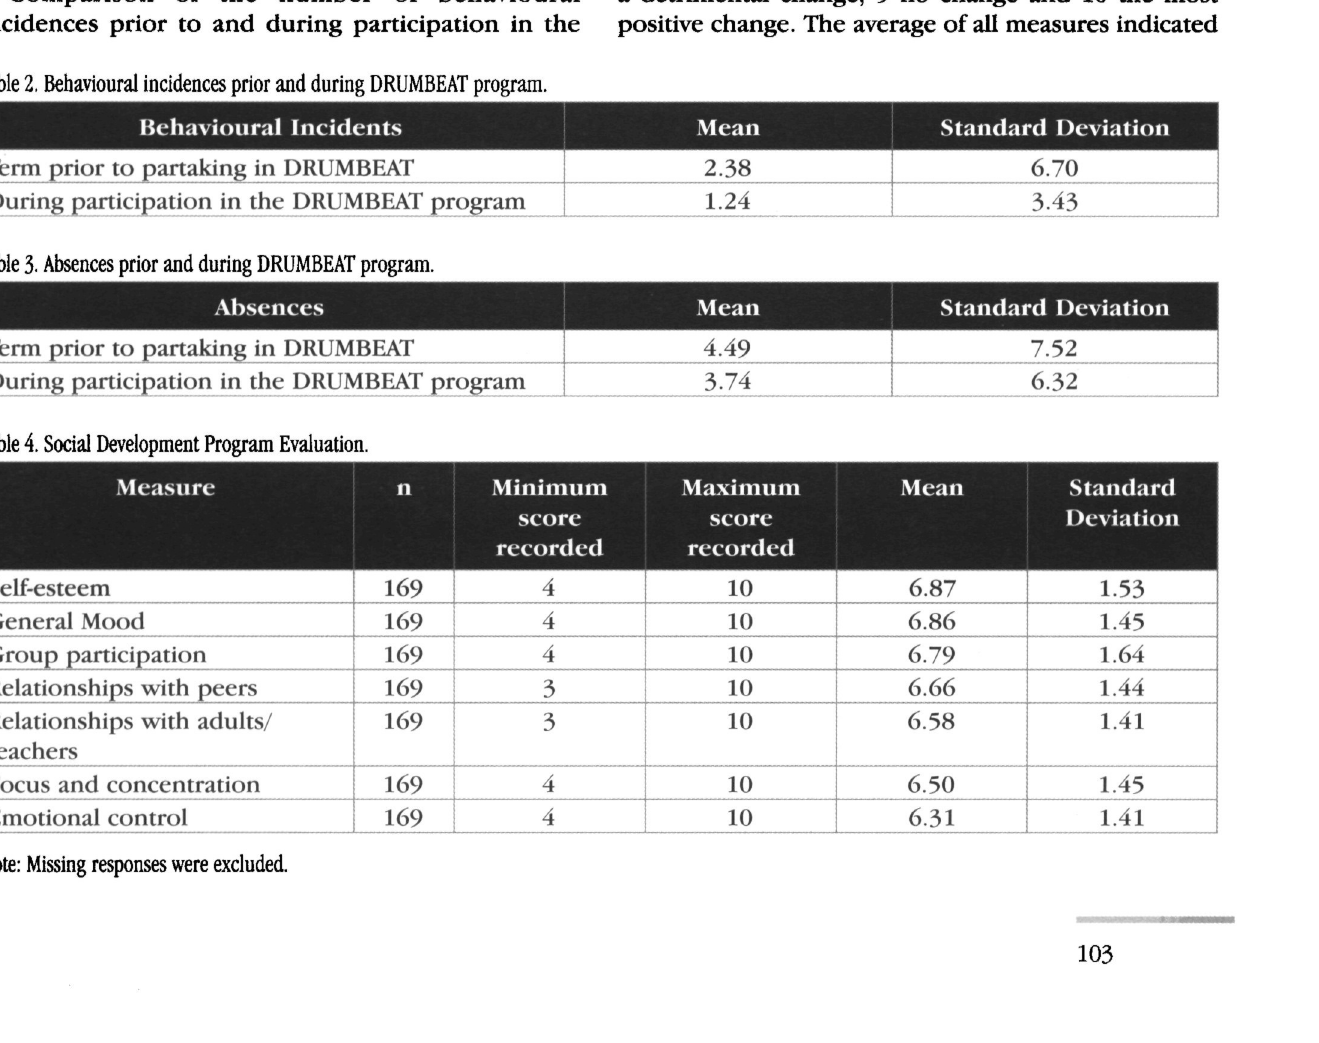
Table 4. Social Development Program Evaluation.